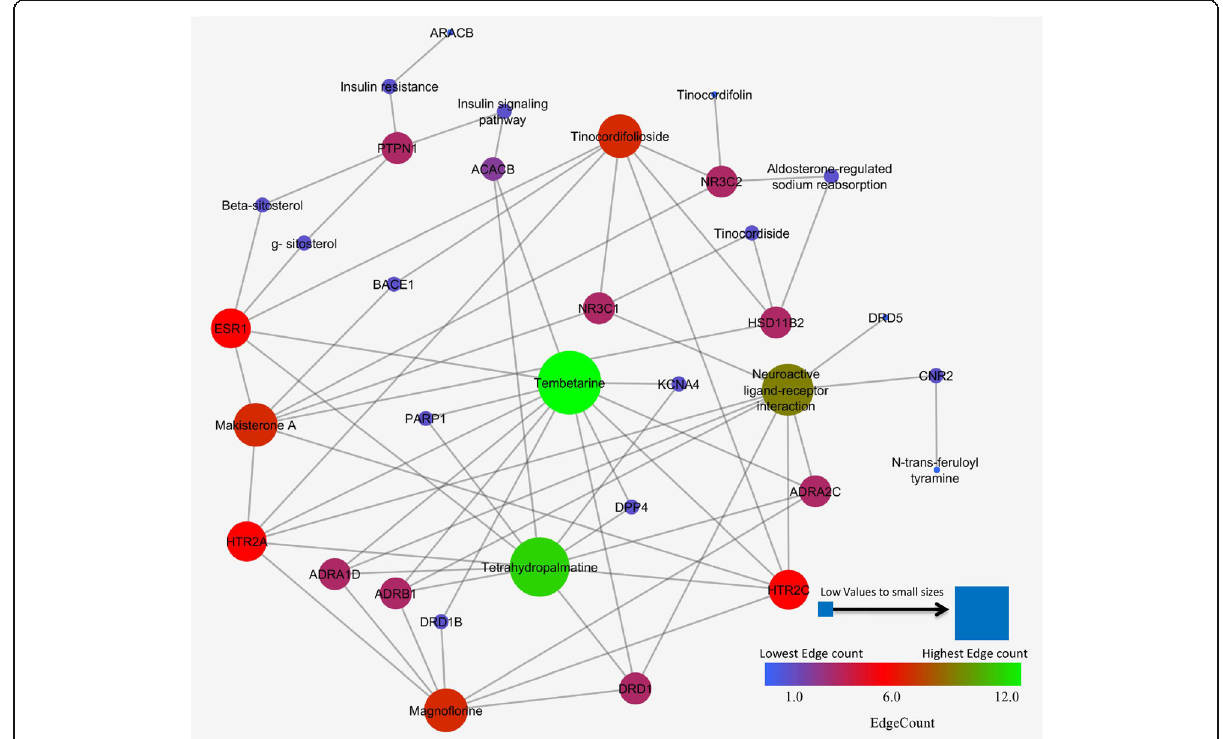
Fig. 4 Network representation of interaction between phytoconstituents, targets and pathways